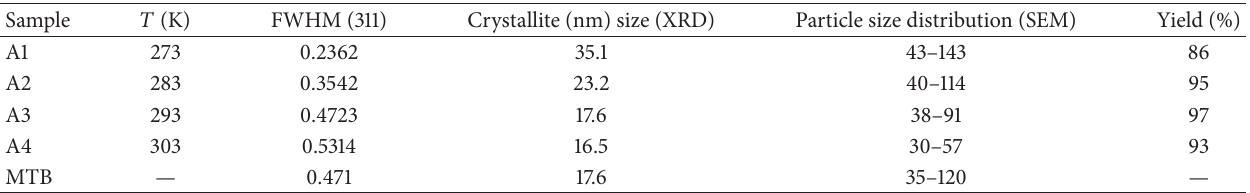
Figure 1: A schematic presentation pathway of chemical preparation of magnetite and biosynthesis of magnetite and their particles size distributions. Table 1: The yield of magnetites prepared at different temperatures and their crystallite size and particle size distribution.